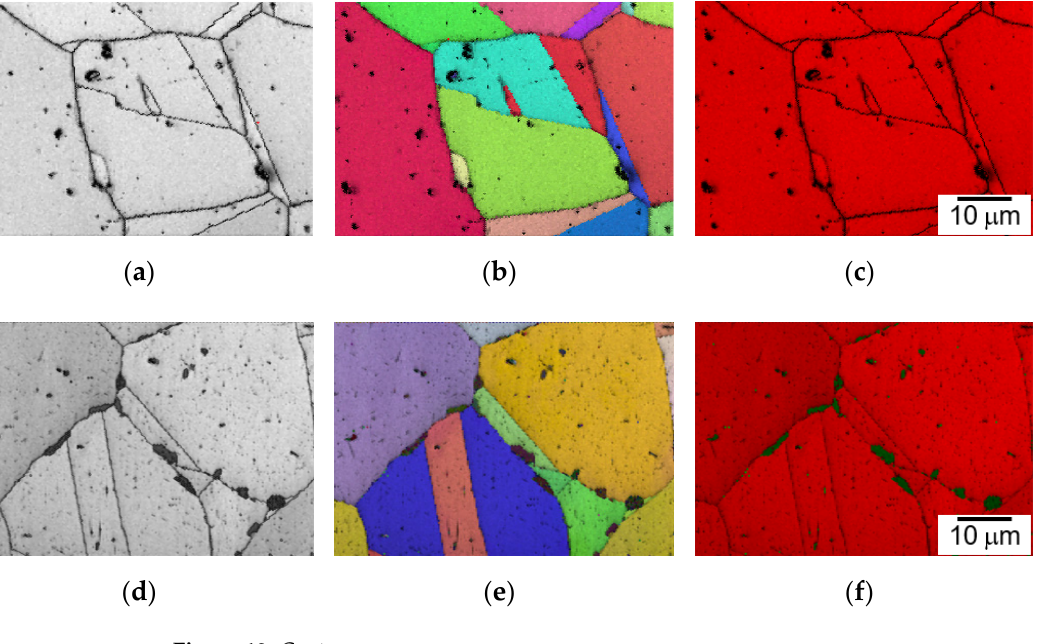
Figure 9. ECCI micrographs from cross-sectional fractures of creep specimens: ( a ) 700 °C/180 MPa/398 h, ( b ) 700 °C/90 MPa/9411 h, ( c ) 750 °C/150 MPa/222 h, and ( d ) 750 °C/70 MPa/4680 h. The EBSD micrographs of 398 h and 9411 h crept specimens at 700 °C are shown in Figure 10. As shown in Figure 10a–c, there is no σ phase observed at 398 h. At 9411 h, the blocky σ phase formed along the high-angle grain boundaries, as presented in Figure 10d–f.